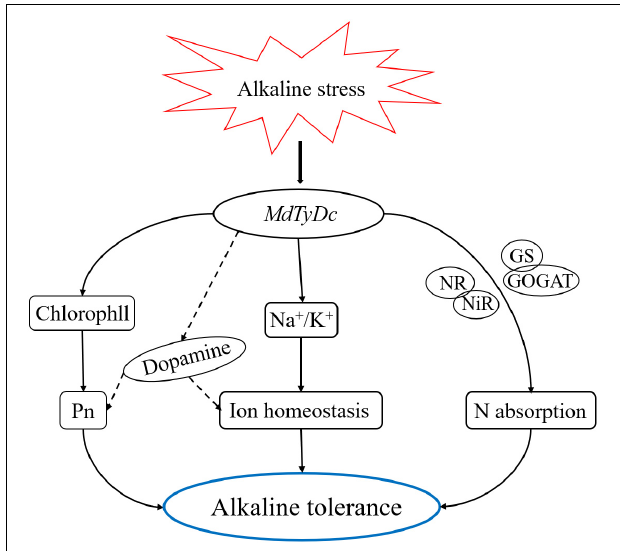
FIGURE 9 | A model to explain the regulatory effect of MdTyDc on apple’s alkaline stress response. Under alkaline stress, apple lines overexpressing MdTyDc showed increased photosynthetic pigment content and inhibited the increase of sodium ions, thus the photosynthetic capacity was enhanced and intracellular ion homeostasis was maintained, which may be realized by increasing dopamine content; In addition, overexpression of MdTyDc also improved the enzyme activity related to nitrogen metabolism, thus promoting nitrogen absorption. Therefore, the alkaline tolerance of transgenic apple plants was